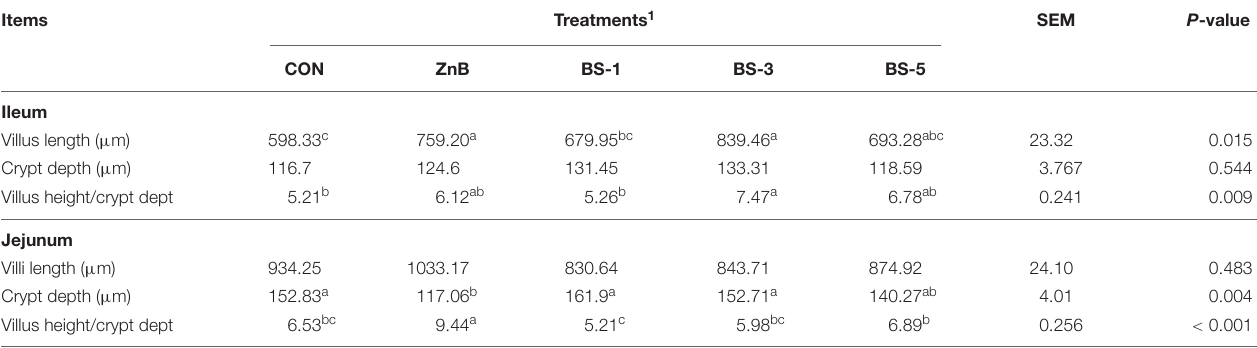
TABLE 4 | Effect of dietary supplementation of Bacillus subtilis ATCC19659 on intestinal morphology of the ileum and jejunum in broilers. Items Treatments 1 SEM P